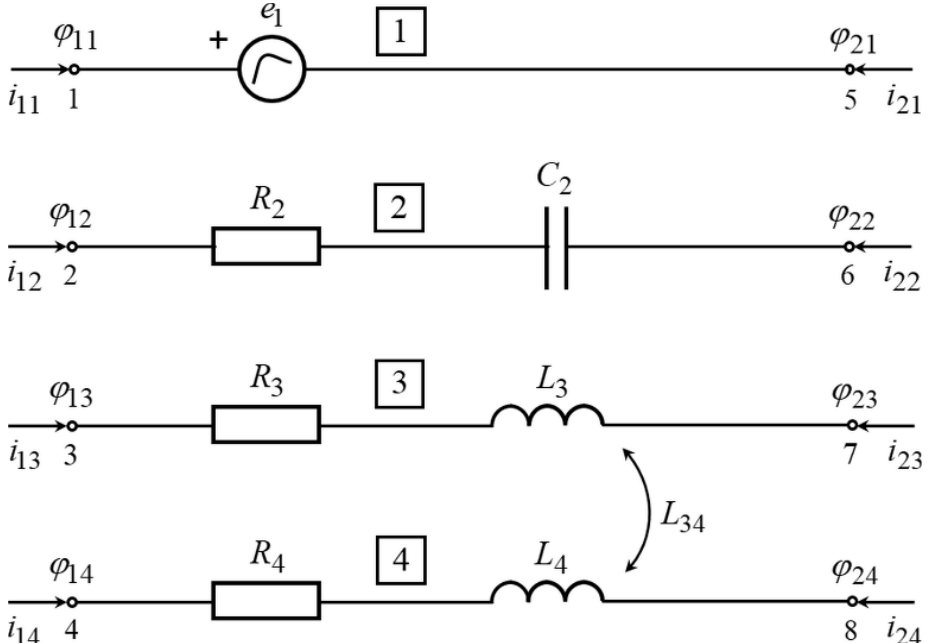
Figure 3. Coupled linear circuit finite element.